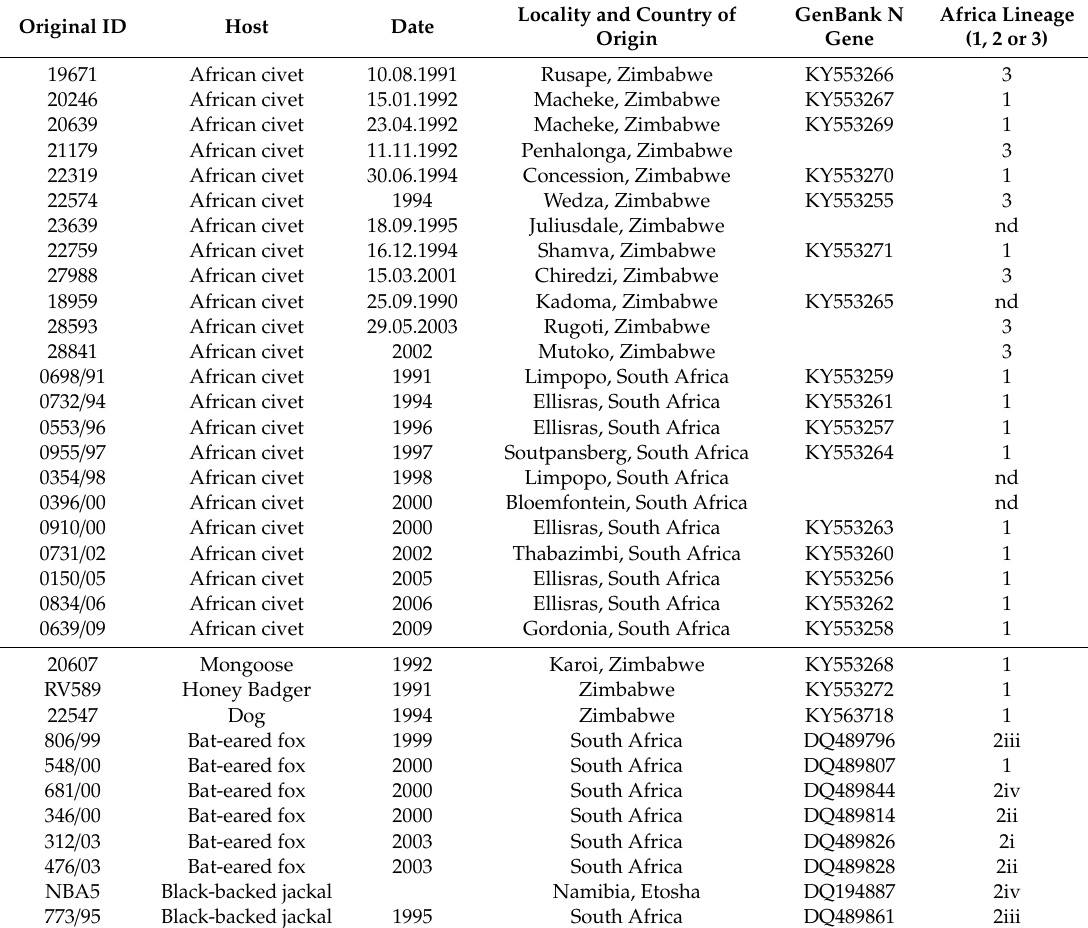
Table 1. Details of all known RABV positive African civets both from this study and historically, including details of additional relevant RABV positive samples obtained during the